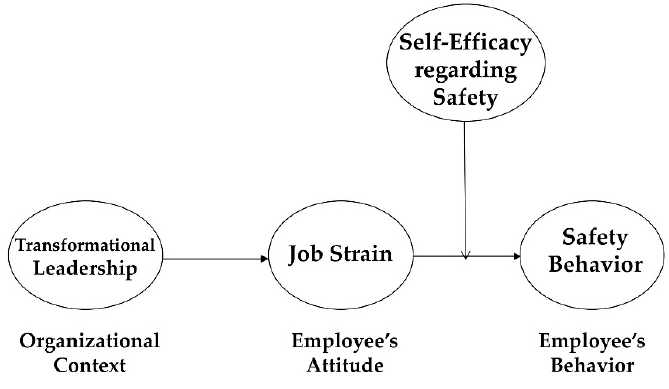
Figure 1. Framework of research model.